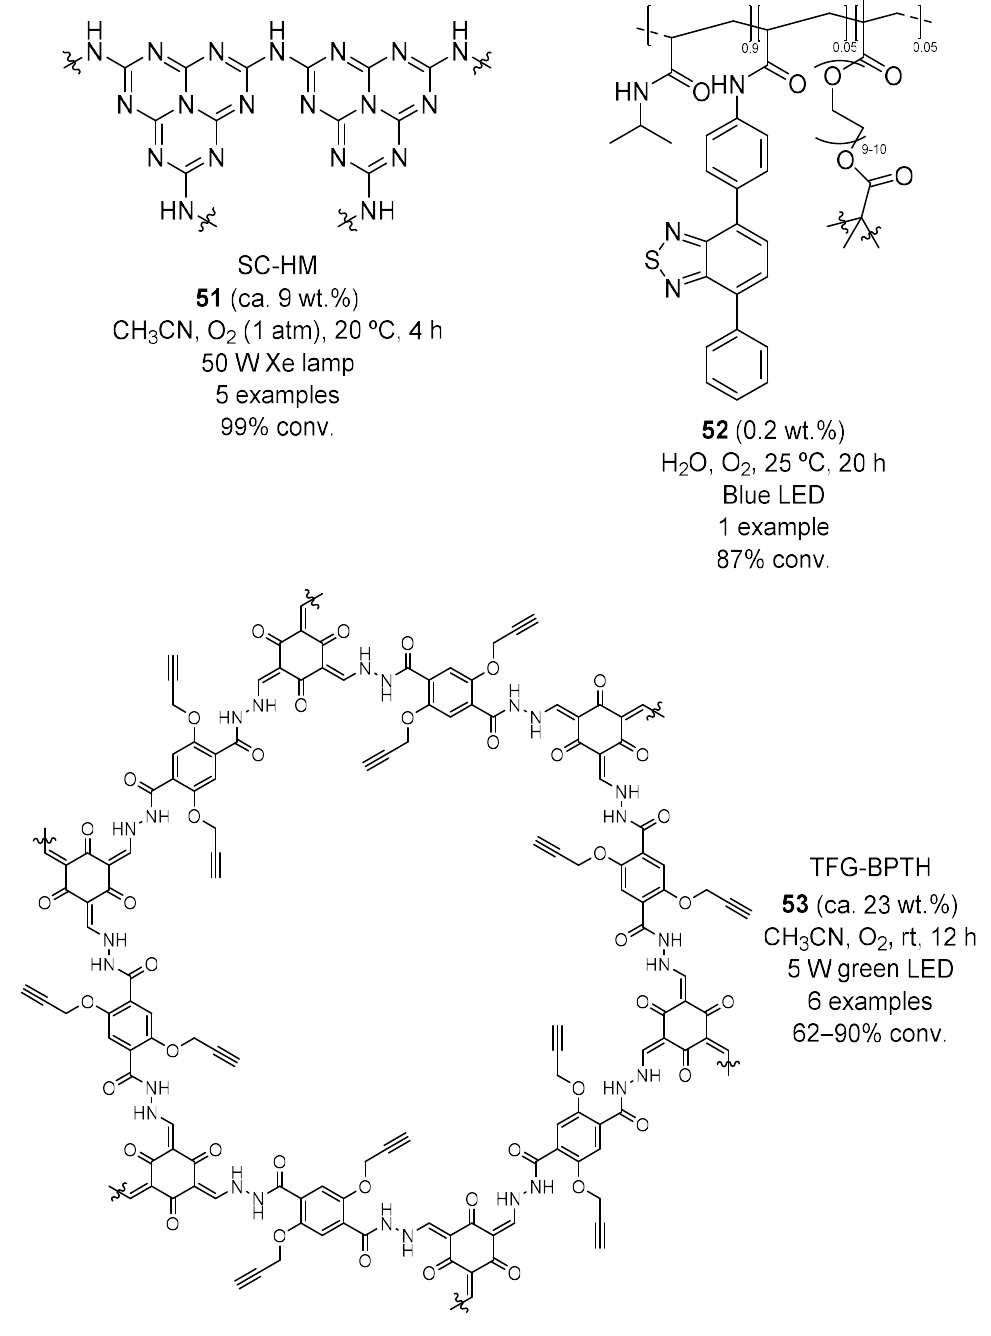
Figure 10. Results obtained in the aerobic photo-oxidative coupling of benzylamines to N -benzylidene benzylamines 2 catalyzed by 51 – 53 .